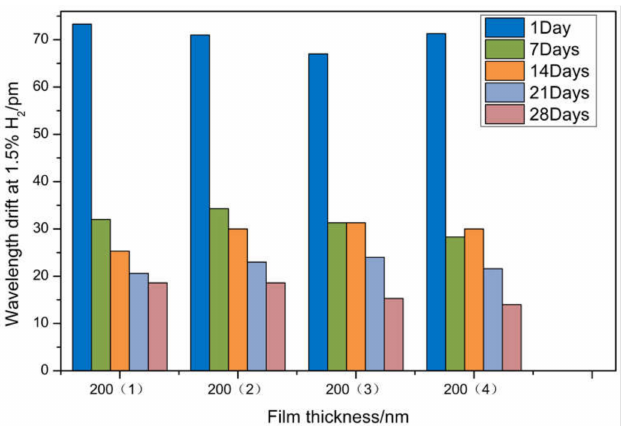
Figure 12. Wavelength drift of hydrogen sensors with different thicknesses at 1.5% H 2 .